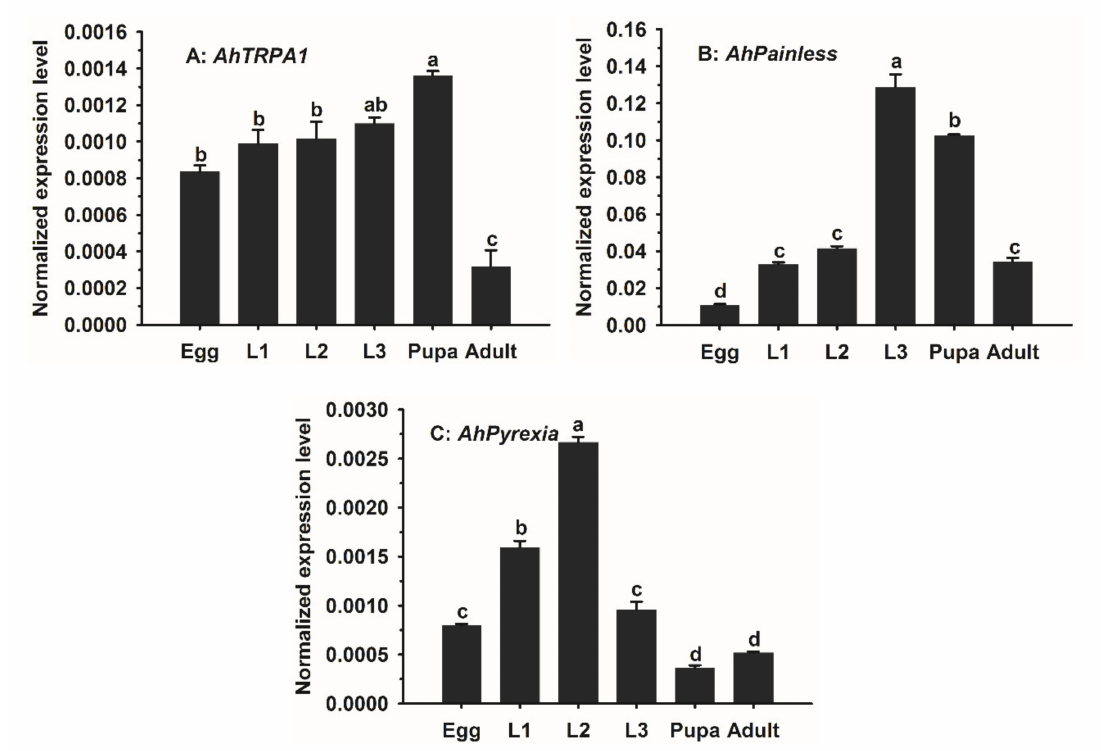
Figure 3. Developmental expression profiles of ( A ) AhTRPA1 , ( B ) AhPainless , and ( C ) AhPyrexia in Agasicles hygrophila . Each developmental stage comprised three biological replicates. Data of the bar chart are expressed as mean ± SE. The di ff erences in the expression during di ff erent developmental stages were analyzed using one-way ANOVA and Turkey’s honest significant di ff erence (HSD) test. Di ff erent lowercase letters represent significant di ff erences at p <